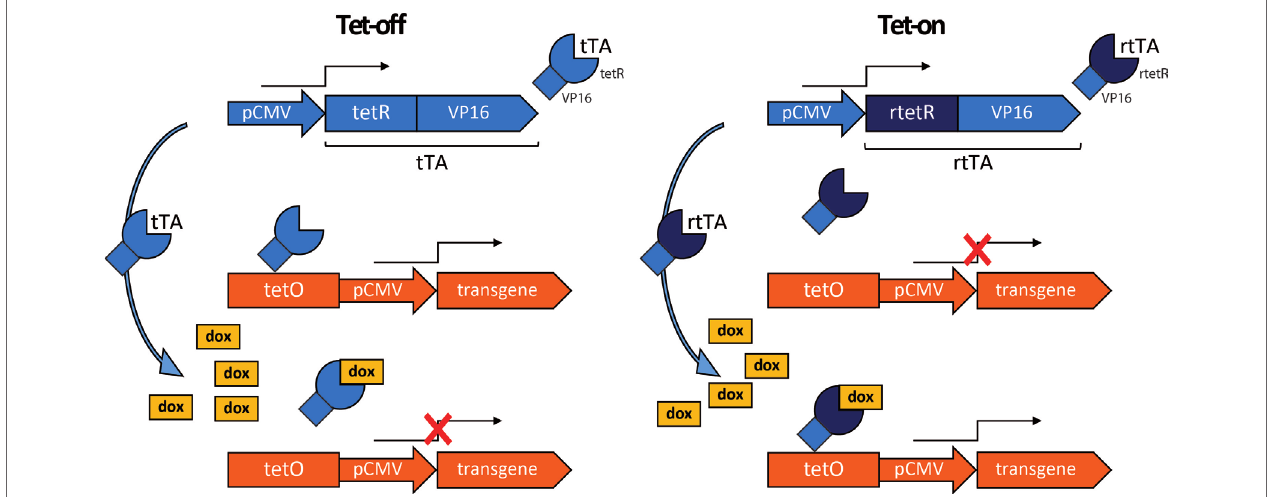
FIGURE 3 | Tetracycline regulation system. In this example, the constitutively active human cytomegalovirus promoter (pCMV) drives the expression of the tetracycline transactivator (tTA) or of the tetracycline reverse transactivator (rtTA), consisting respectively of the tet-repressor (tetR) or reverse tet-repressor (rtetR) fused to the VP16 transactivation domain. Tet-off: tTA binds the tet operator (tetO) to drive transgene expression in the absence, but not in the presence of doxycycline (dox). Tet-on: rtTA binds to tetO and drives transgene expression in the presence, but not in the absence of